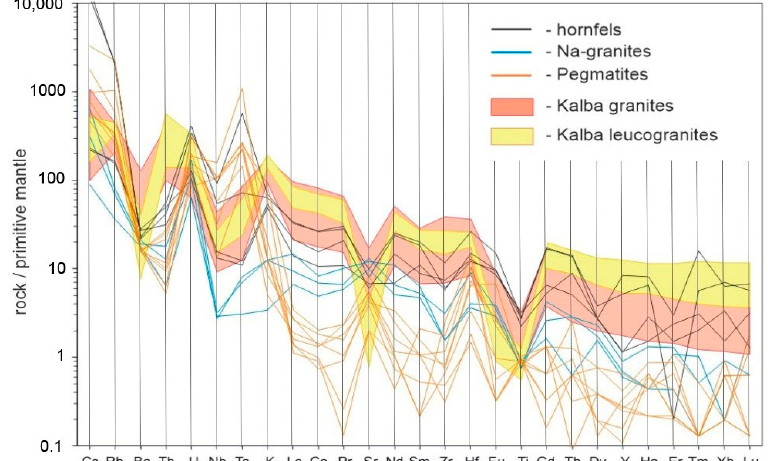
Figure 13. Distribution (spider diagram) of trace elements of rare metals in hornfelses, Na-granites, and pegmatites of the Tochka deposit in comparison with the Kalba granites and leucogranites. The composition of the Kalba granites and leucogranites are taken from [24,47]. The concentrations are normalized to the primitive mantle [56].